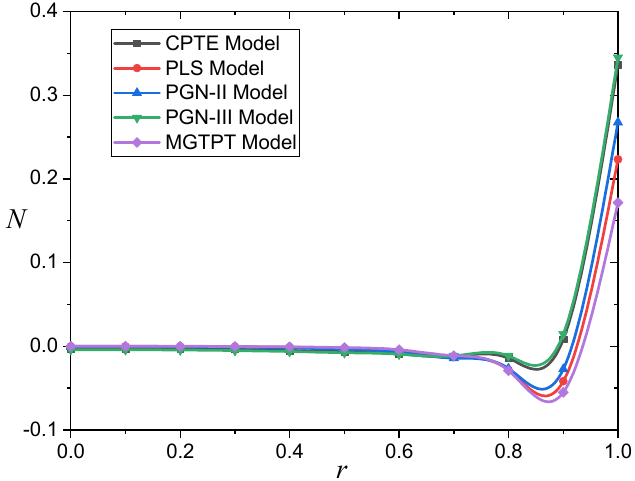
Figure 3. The carrier density N under different photothermal models.